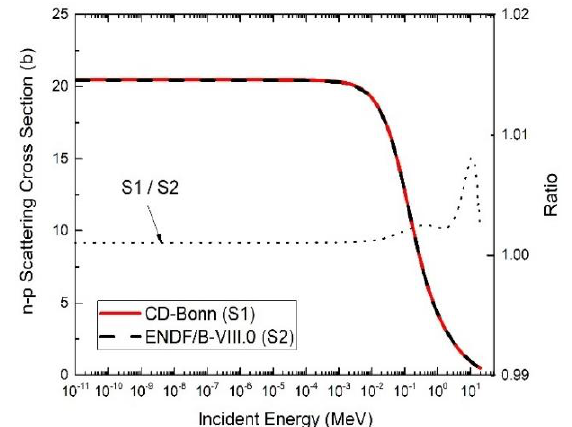
Fig. 2. The evaluated results for neutron-proton scattering data based on the CD-Bonn